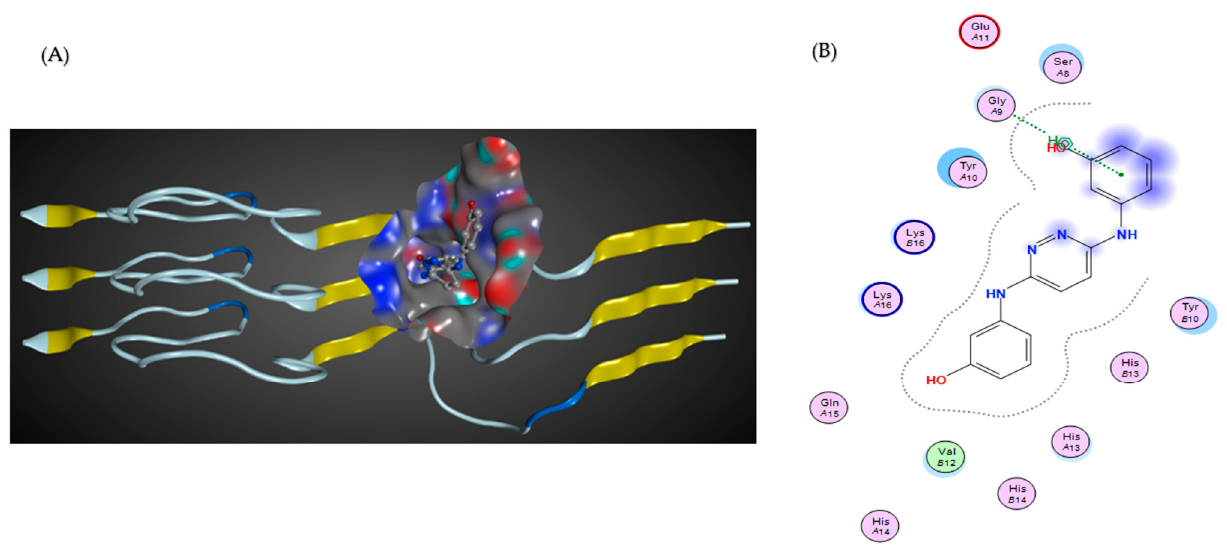
Figure 3. The predicted interactions of the RS-0406 molecule with A β as a trimer in 3D (A) and 2D (B). The trimer is depicted as a ribbon diagram, and RS-0406 is shown as a ball-and-stick model. The molecular surface represents the interaction between protein and ligand structures [145].